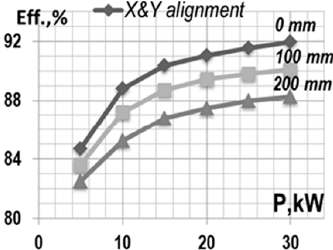
Figure 15. IPT e ffi ciency vs output power and X&Y misalignment with 100 mm vertical air gap and Figure 15. IPT efficiency vs output power and X&Y misalignment with 100 mm vertical air gap and power of 5–30 power of 5–30 kW.